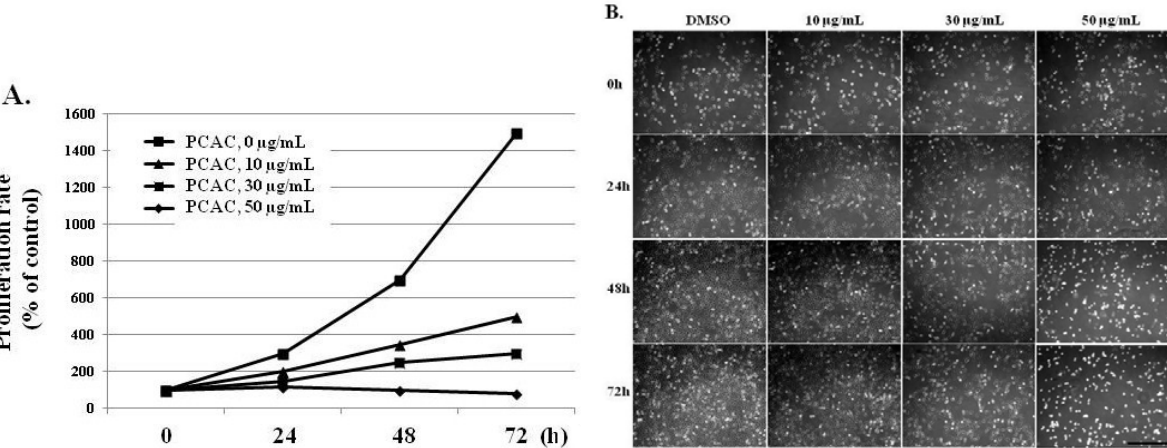
Figure 2. Effects of PCAC on the proliferation and viability of MDA-MB-231 cancer